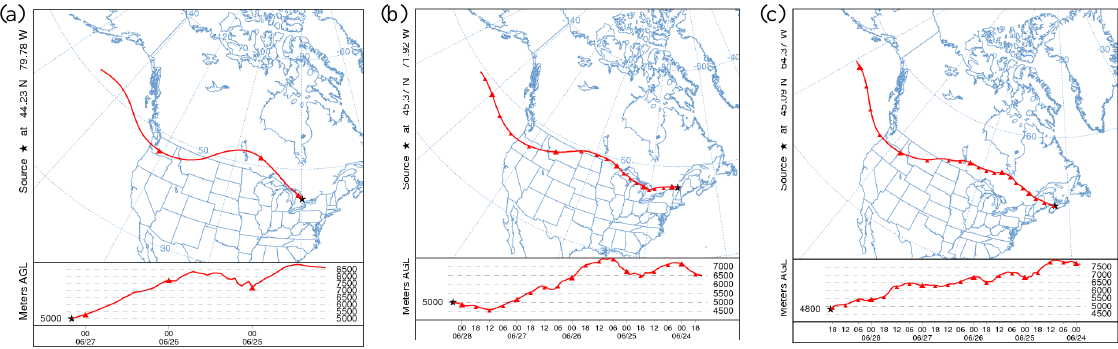
Fig. 10. HYSPLIT five-day back trajectories ending at (a) CORALNet Egbert (b) CORALNet Sherbrooke and (c) CORALNet Acadia site locations.